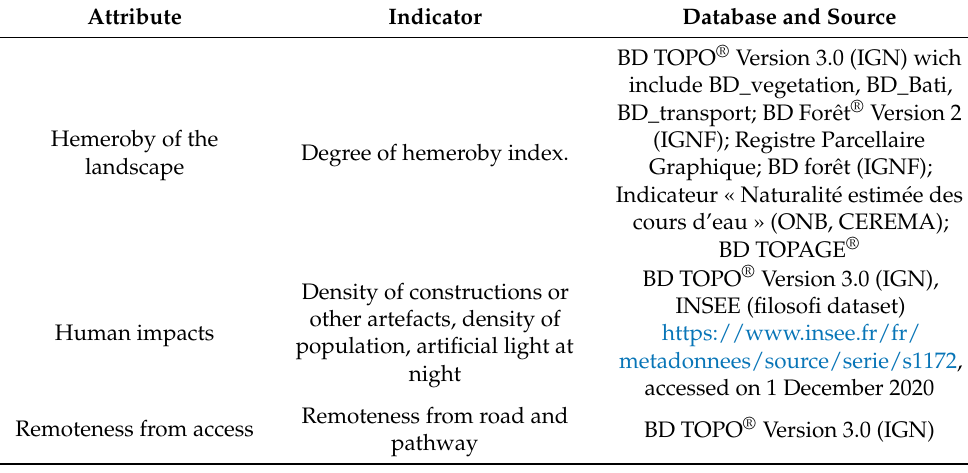
Table A2. Spatial databases and indicators used for each of the three naturalness attributes.